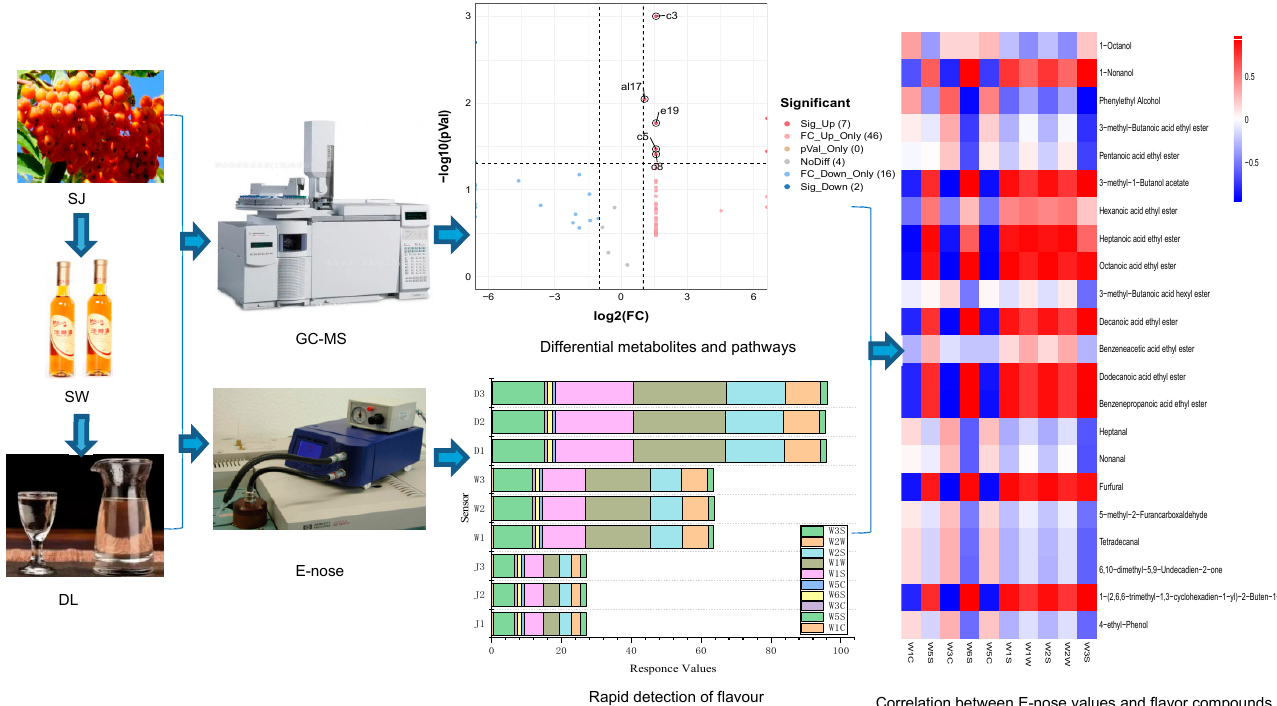
Figure 1. The whole research process.